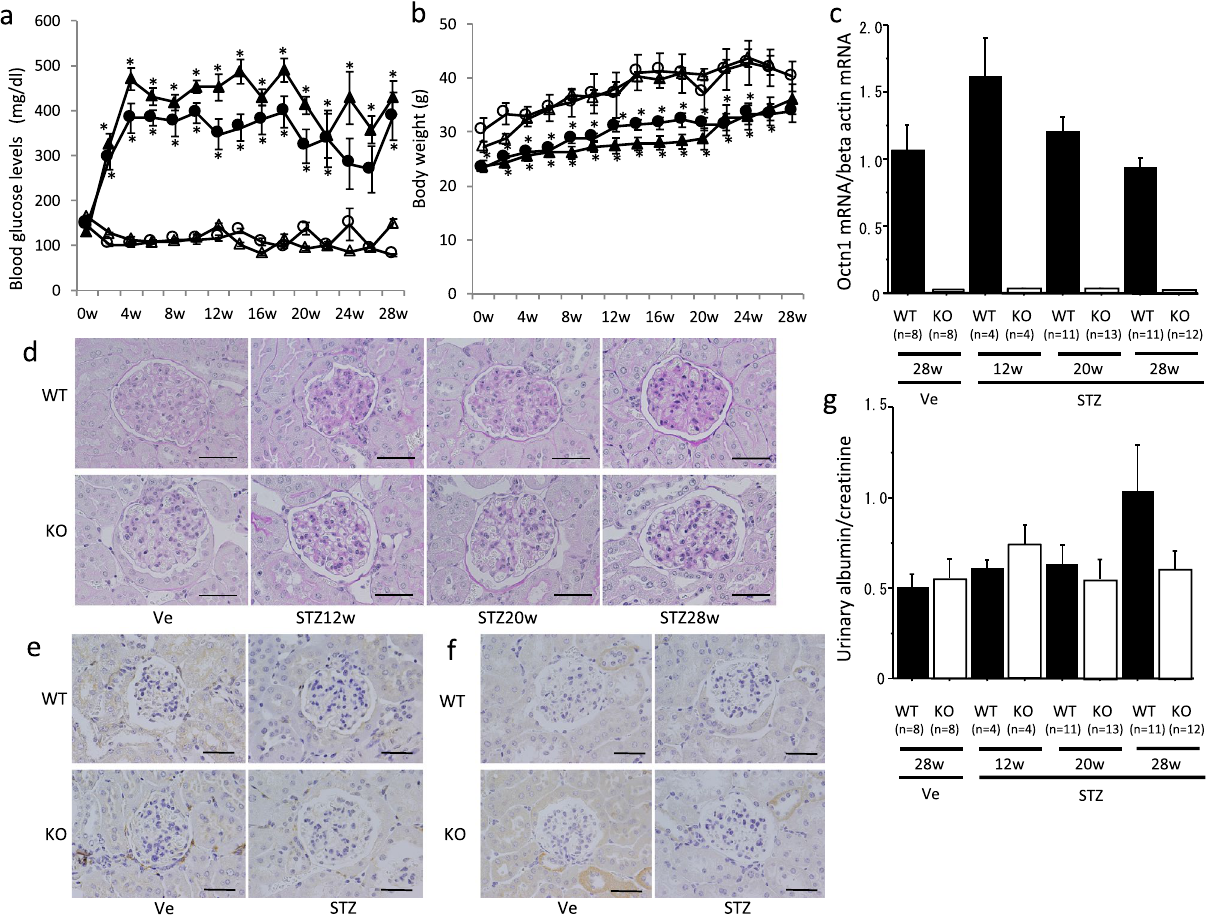
Figure 1. Glomerular lesion in STZ-induced diabetic mice. STZ or Vehicle control (Ve) solution was injected into the intraperitoneal cavity of 6–8 week-old male octn1 KO and WT mice. Blood glucose levels ( a ) and body weight ( b ) of the octn1 KO and WT mice (circle: WT-Ve, triangle: KO-Ve, filled circle: WT-STZ, filled triangle: KO-STZ) were shown. OCTN1 mRNA expression was only detected in the WT mice ( c ). Glomerular images by PAS staining were shown in panel ( d ) before and after STZ injection. F4/80-positive ( e ) and CD3-positive cells ( f ) were faintly detected in the glomeruli. Urinary levels of albumin in the octn1 KO and WT mice was almost no increase throughout the observation period ( g ). KO, octn1 KO mice; WT, wild-type mice; STZ, STZ injected mice; Ve, vehicle control.* P < 0.05 for each control. The scale bar represents 100